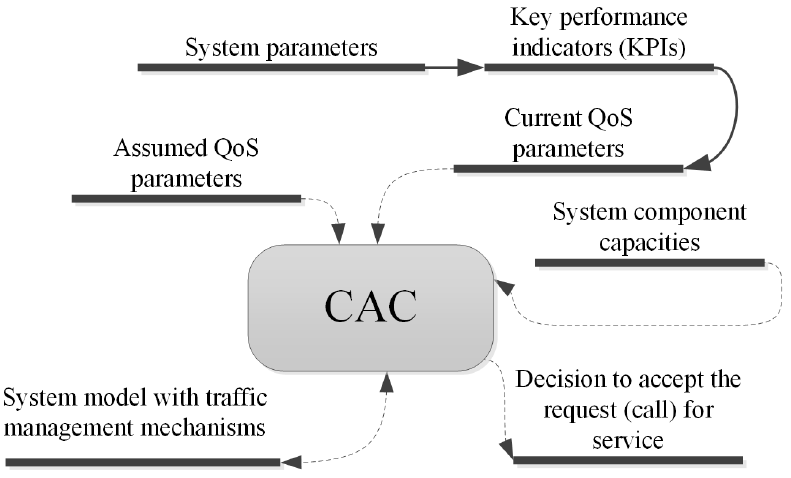
Figure 1. The concept of the CAC